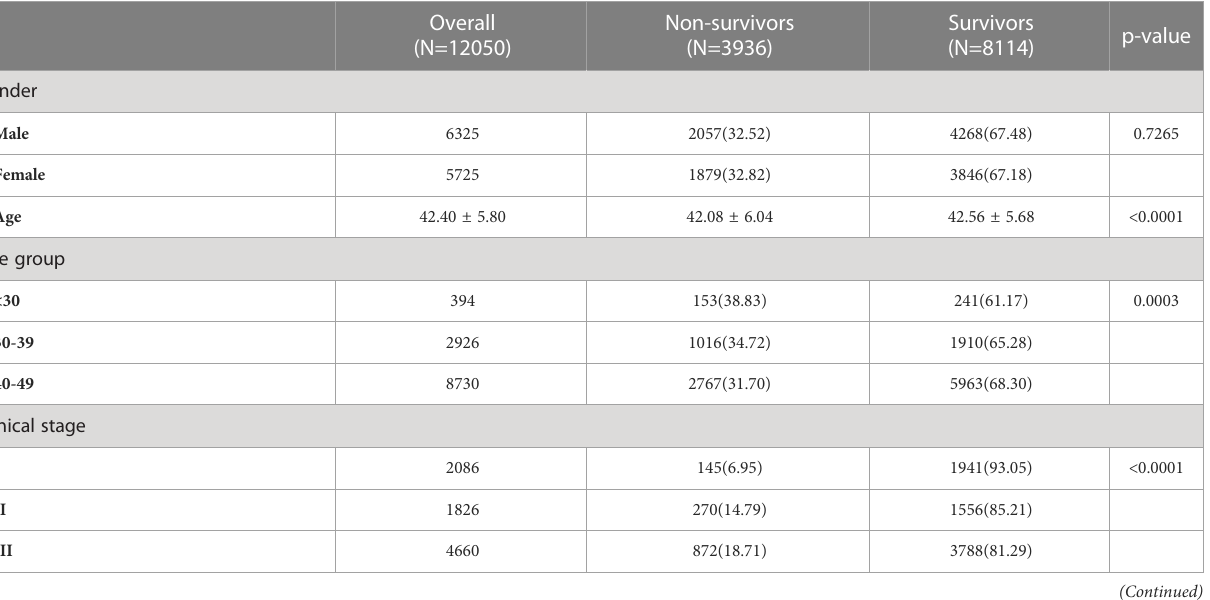
TABLE 1 The characteristics of EO-CRC